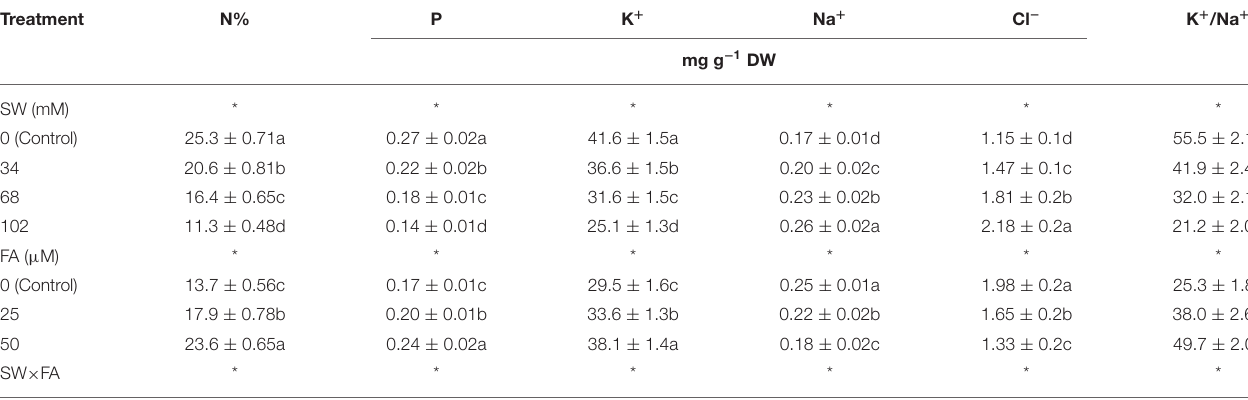
TABLE 5 | The effect of SW irrigation and FA spraying on leaf elemental status of Plectranthus amboinicus plants grown under greenhouse conditions. Treatment